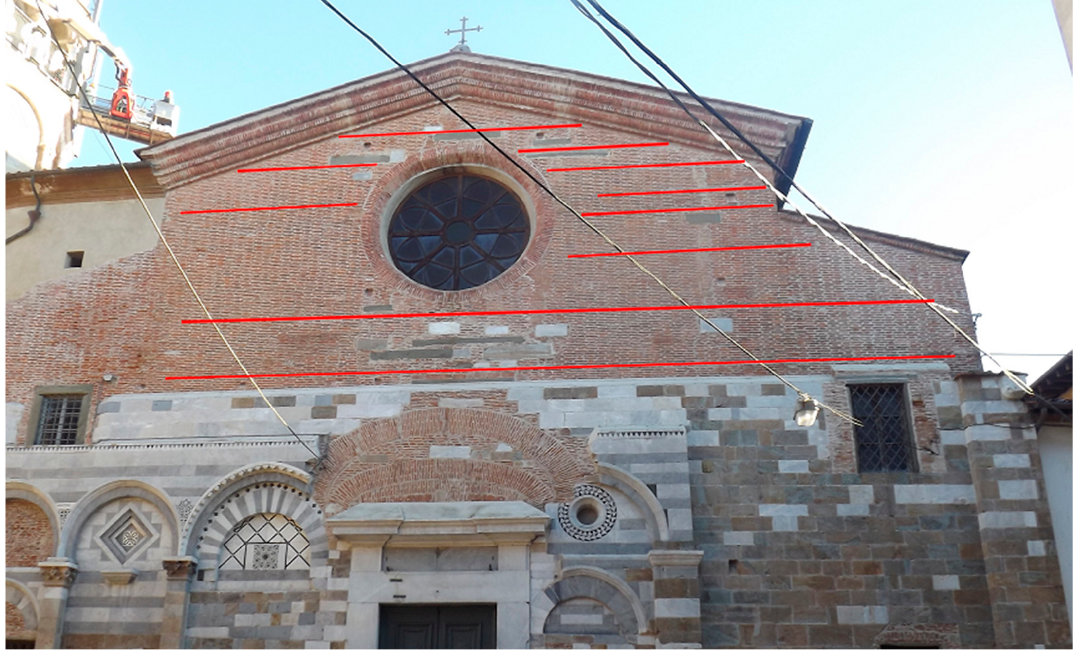
Figure 24. Strengthened brick courses of the main façade.